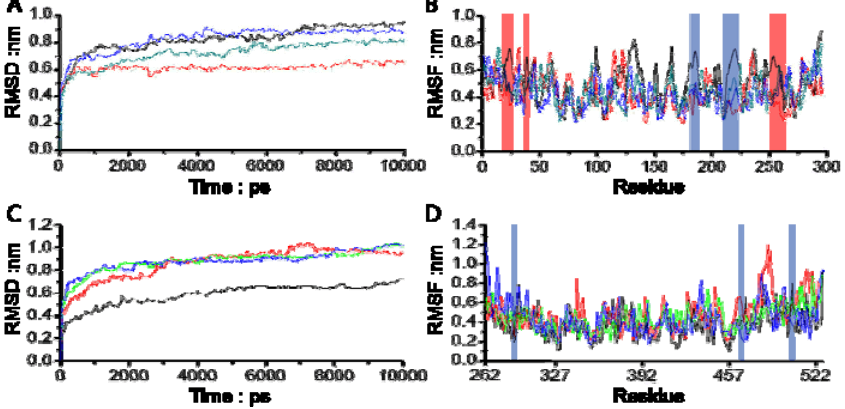
Figure 4. Analysis of the molecular dynamics simulations. ( A ) The The root mean square deviation (RMSD) for all backbone atoms in four simulations of PTP1B system; ( B ) The root mean square fluctuations (RMSF) for side-chain atoms in four simulations of the PTP1B system; ( C ) The RMSD for all backbone atoms in four simulations of the SHP-2 system; ( D ) The RMSF for side-chain atoms in four simulations of the SHP-2 system. The curves colored in grey indicate the systems of PTP1B ( A , B ) and SHP-2 ( C , D ) without any compounds, while the curves of PTP1B ( A , B ) and SHP-2 ( C , D ) with the novel Compounds 13 , 15 and 20 are colored in magenta, green and blue, respectively. The curves associated with catalytic site and site B in Figure 4B,D are indicated by blue and red squares,